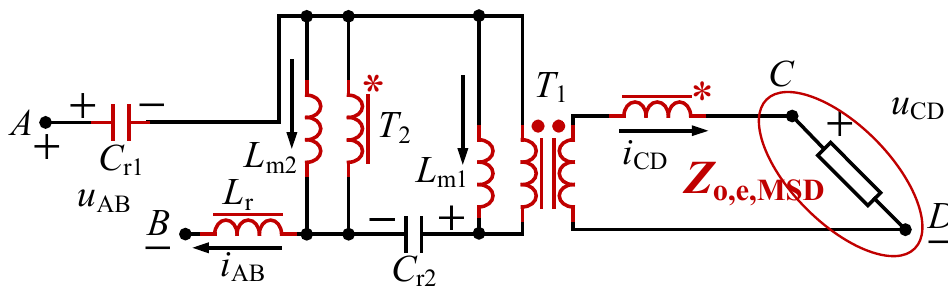
Figure 9. Equivalent FHA circuit in step-down mode (The symbols of “*” are dotted terminals of T 2 ).